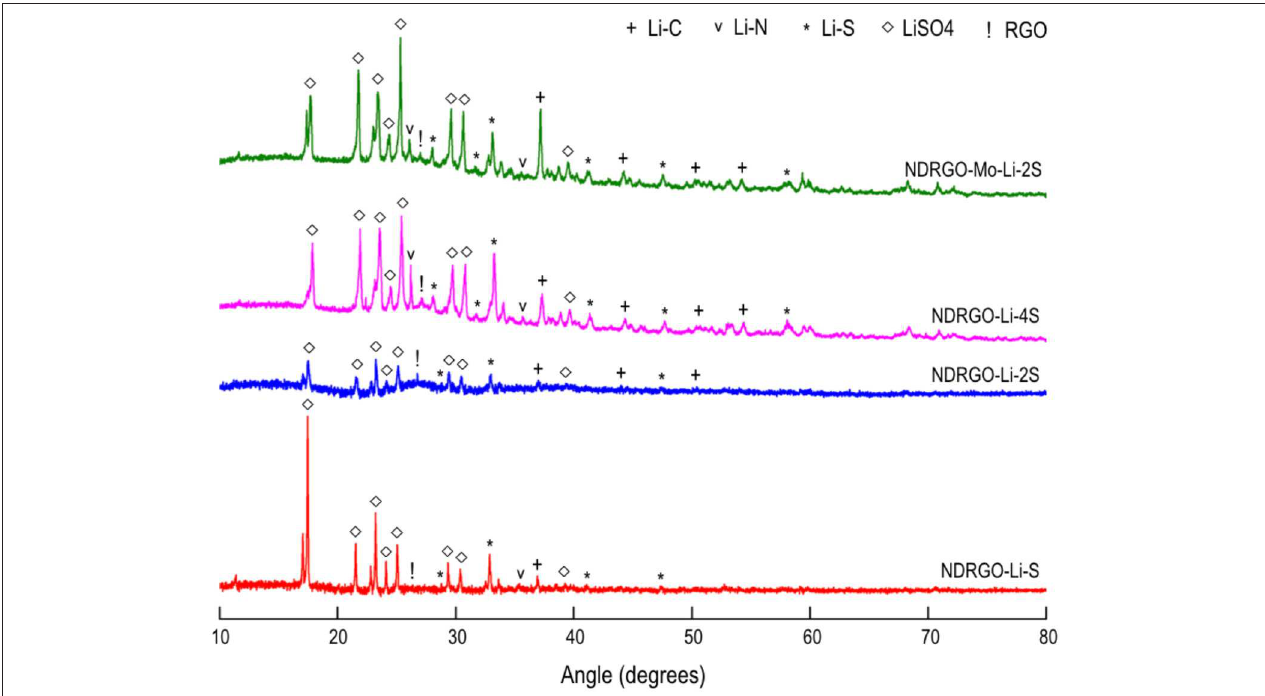
FIGURE 3 | XRD pattern of the synthesized